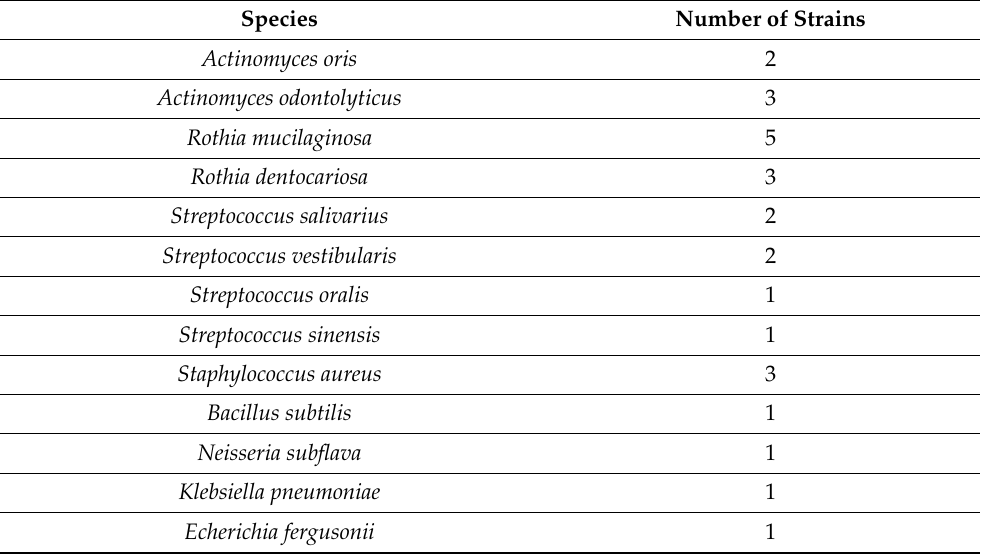
Table 1. Isolated nitrate-reducing bacteria from